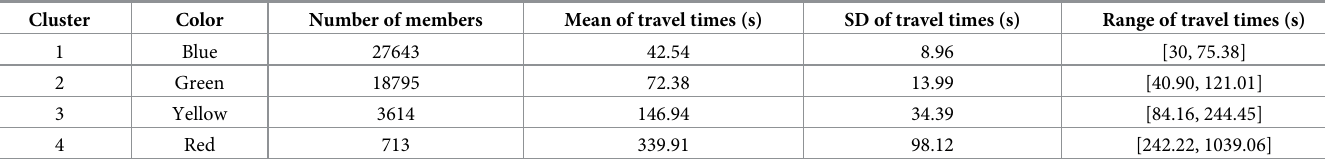
Table 7. Descriptive statistics of